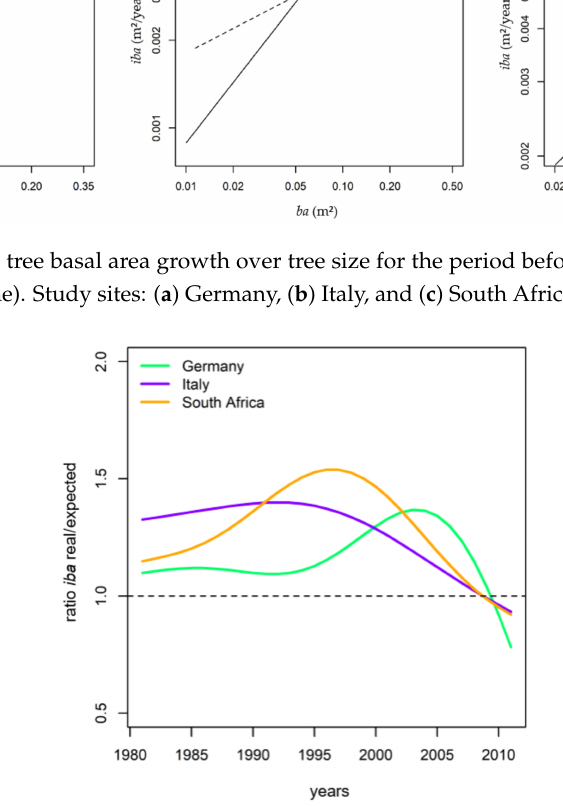
Figure 6. Ratio of real to expected individual tree basal area increment growth, pictured for recent periods after 1980. The dotted line at 1.0 on the Y -axis indicates the expected growth as predicted by the growth